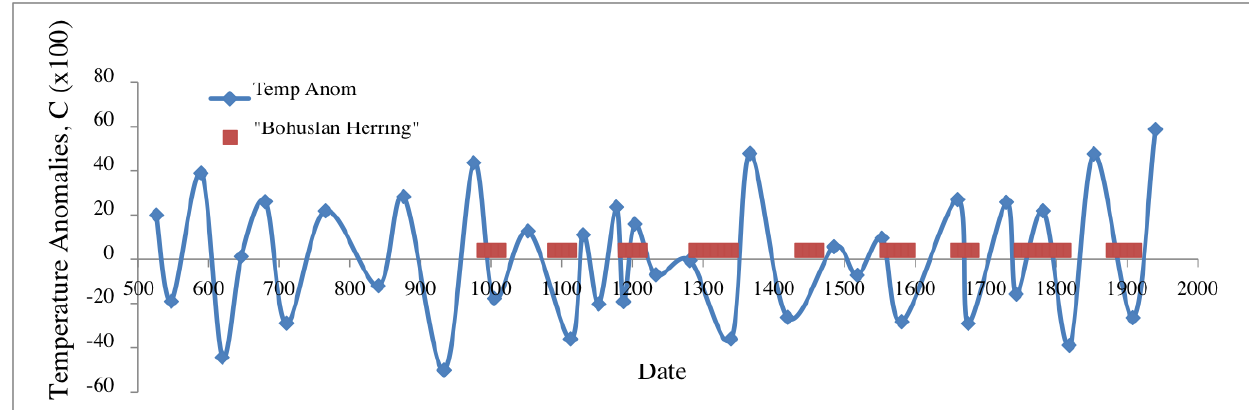
Figure 7. Temperature anomalies, °C, as in Figure 2 (×100) displayed with maximum abundances of Swedish Herring (arbitrary units) adapted from Alheit and Hagen